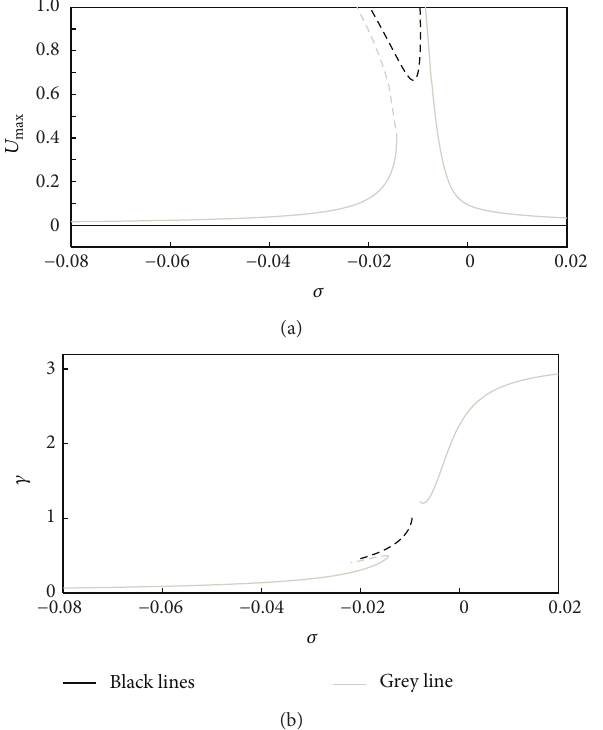
Figure 4: Creation of escape band due to DC bias. AC frequency is near natural frequency. (a) Amplitude-frequency response and (b) phase-frequency response. MMS is used. AC voltage 𝛿 0𝐴 is relatively small (in this case half of the one used in Figures 2 and 3). In each figure two cases are shown: (i) zero DC bias (black lines): 𝛿 0𝐷 = 0.0 and there is no escape band and (ii) nonzero DC bias (grey lines): 𝛿 0𝐷 = 0.0003 and an escape band is created. The AC voltage, fringe, and damping are 𝛿 0𝐴 = 0.05, 𝑓 = 0.26, and 𝑐 = 0.01, respectively.